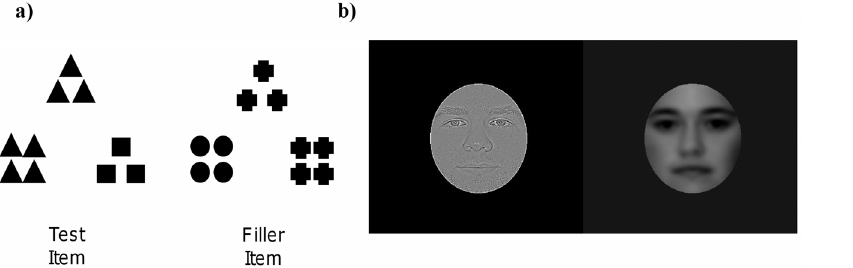
Figure 2. Sample stimuli from the dispositional and manipulation global/local tasks. (a) Sample stimuli from the dispositional global/local shape task. The test triad on the left contains both a global and a local option, whereas the filler triad on the right has only one possible answer, and was not used to measure global/local processing. (b) Sample stimuli from the global/local face manipulation task. A HSF (local) face on the left side and a LSF (global) face on the right.